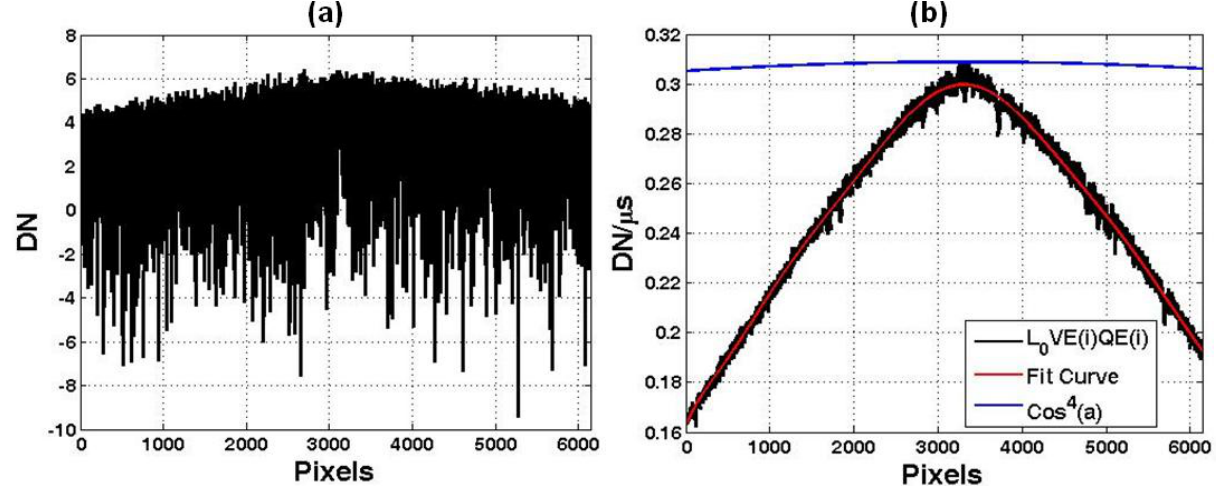
Figure 3. The terms of Equation 2 determined from the Least Square analysis of the 5 sets of images of a uniform target at different integration time, (a) DN QE ( i ). The blue curve in (b) is cos 4 α and the red curve polynomial fit at 9th